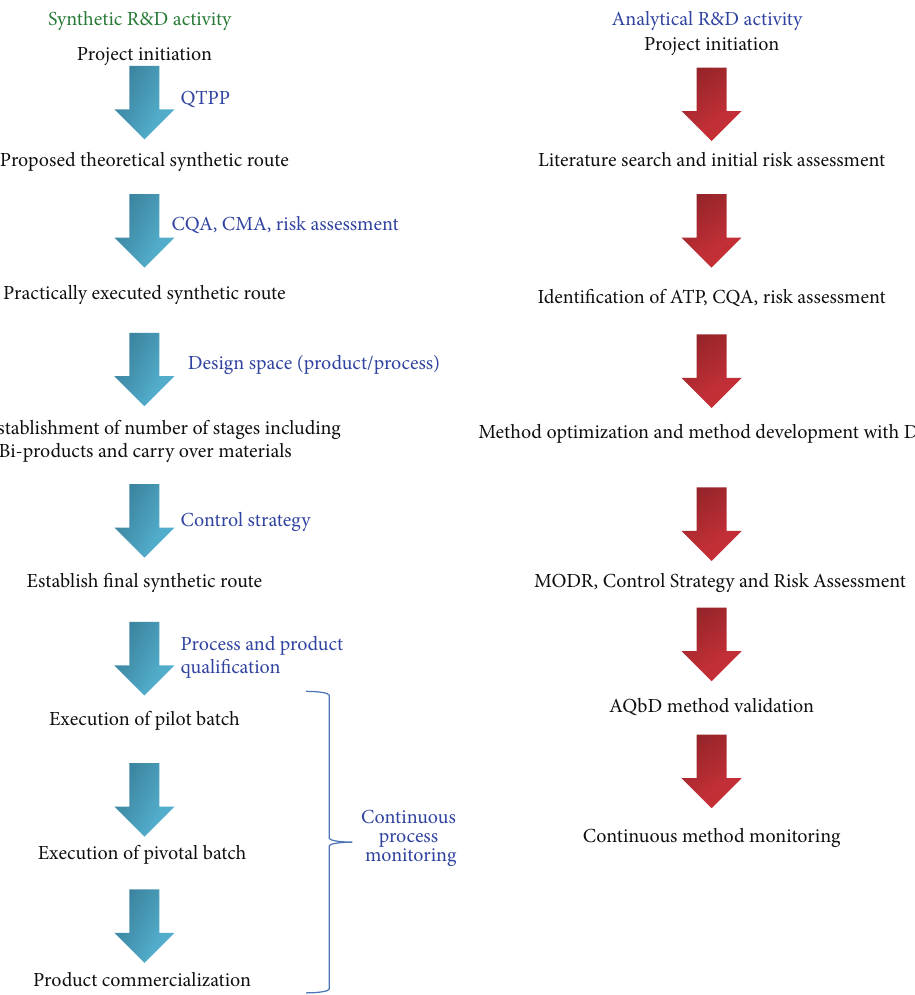
Figure 2: API synthetic development and AQbD